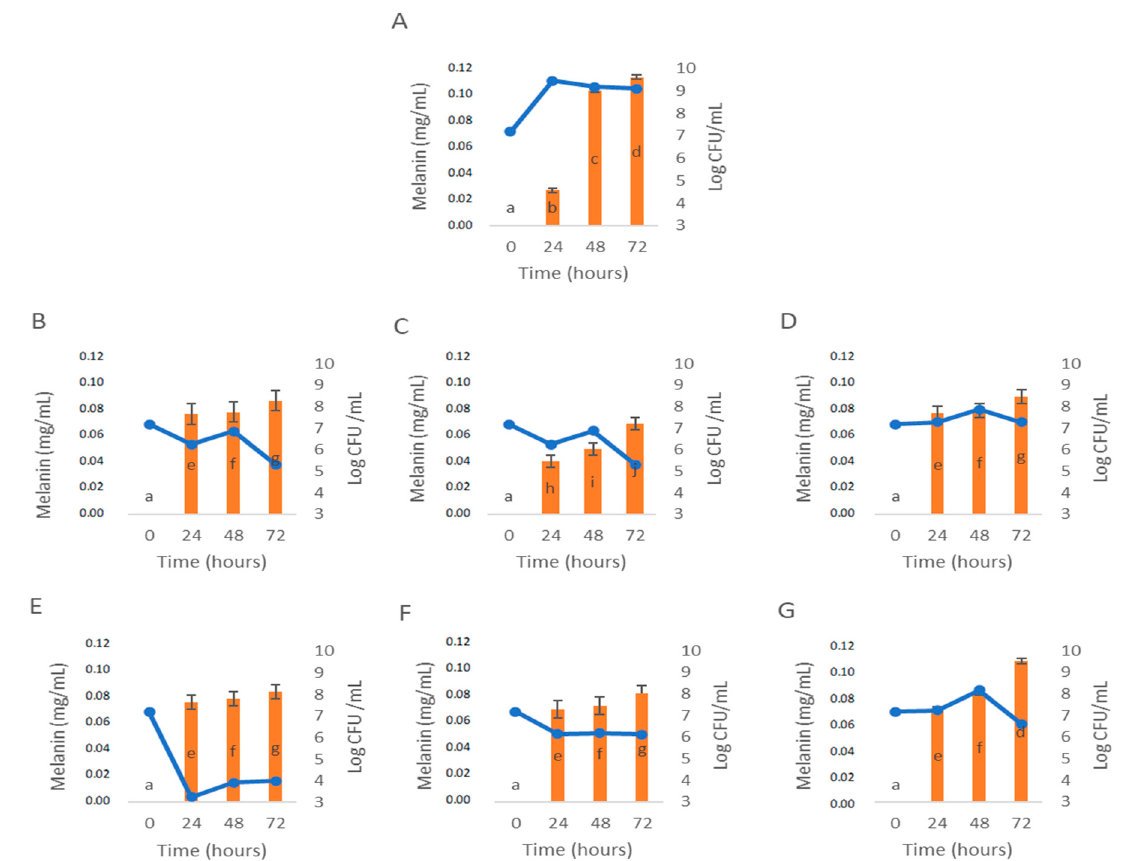
Figure 3. Influence of C. cardunculus extracts and phenolic acids in melanin bioproduction by P. putida ESACB 191. ( A ). Control; ( B ). Rosmarinic acid; ( C ). Chlorogenic acid; ( D ). 50% Chlorogenic acid + 50% Rosmarinic acid; ( E ). Leaf decoction extract; ( F ). Inflorescence decoction extract; ( G ). 50% Leaves decoction + 50% Inflorescence decoction. The concentration 1 mg/mL was used for all samples tested in Müller–Hinton Broth with 1% of L-tyrosine. Lines represent P. putida ESACB 191 growth curve (Log CFU/mL) and bars represent melanin bioproduction